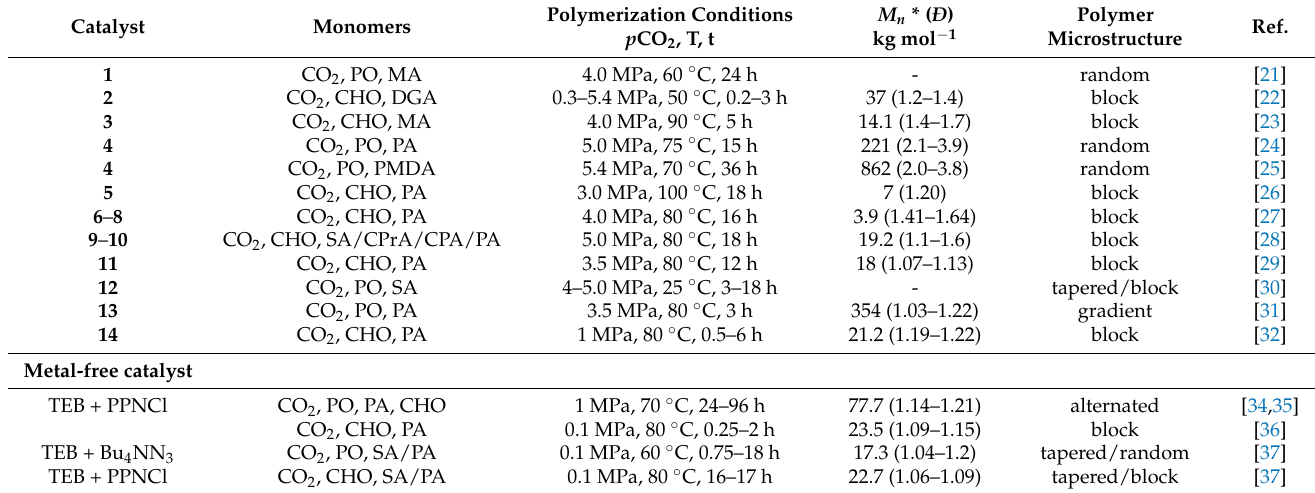
Table 1. Summary of terpolymerization of CO 2 with epoxides and cyclic organic anhydrides.